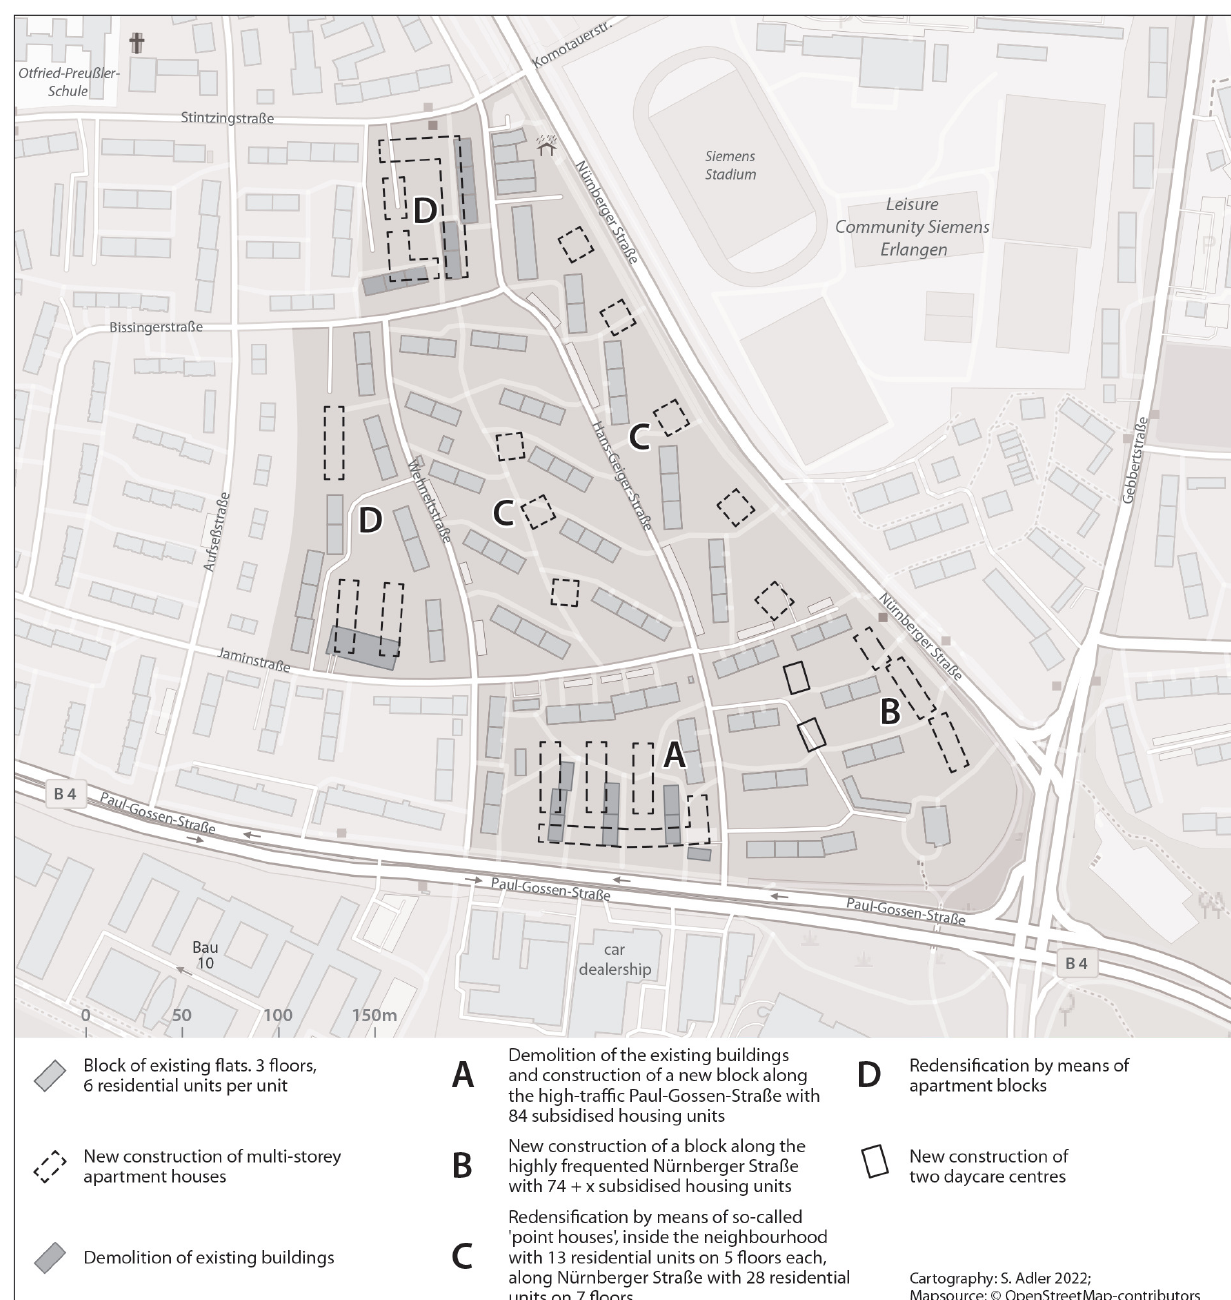
Figure 6. Changes in the housing stock in the course of redensification on the Rathenau estate. Indeed, there are indications that rents could rise by as much as €4.10 “per square metre after renovation is